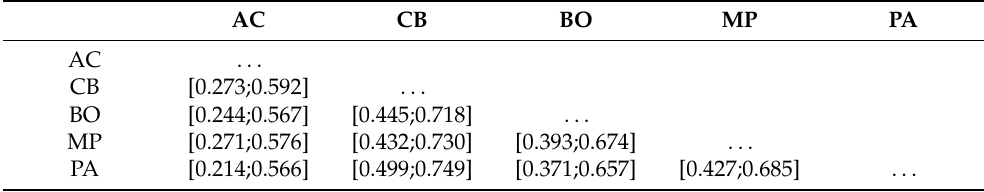
Table 6. Confidence intervals for the correlation between each pair of variables.